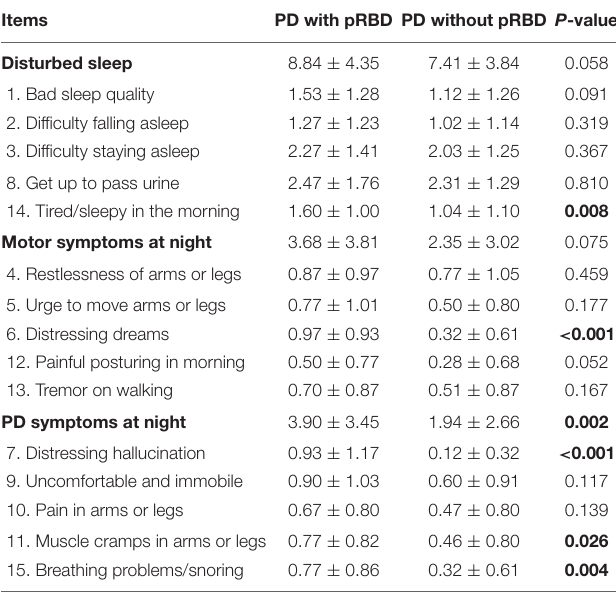
TABLE 2 | Comparison of PDSS-2 subitems between PD patients with and without pRBD. Items